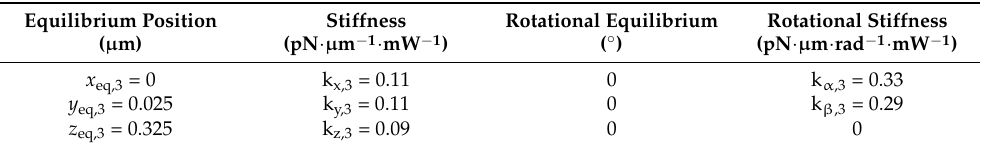
Table 2. Values of the spatial equilibrium, spring constants, rotational equilibrium and torque constants for an RBC trapped by a three-beams optical